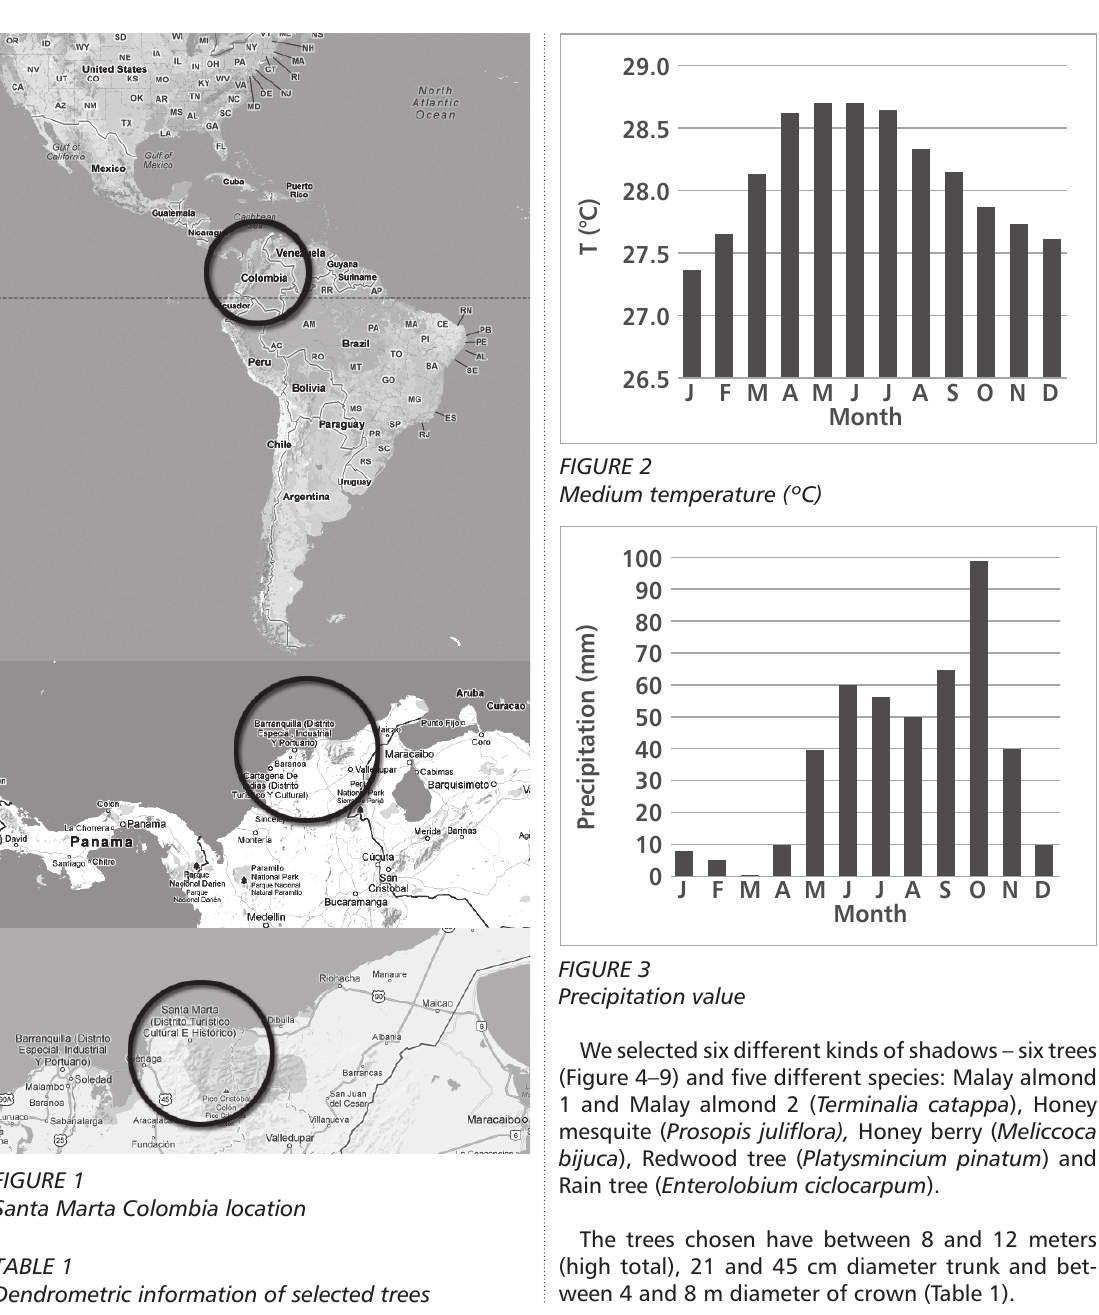
FIGURE 2 Medium temperature (ºC)